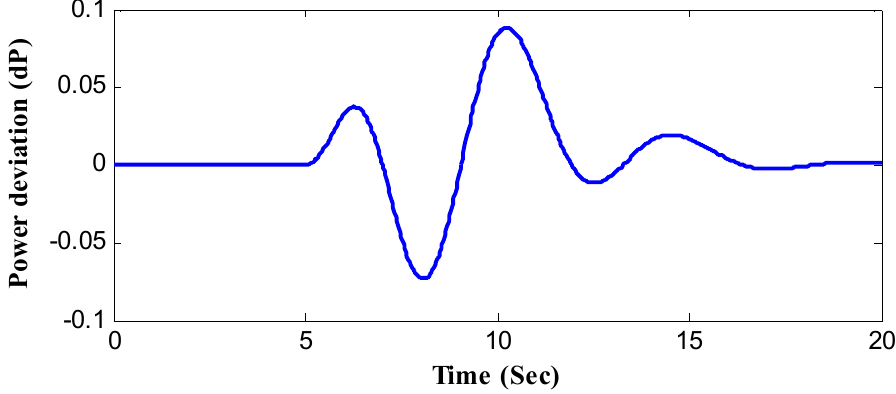
Figure 7. Frequency deviation ( ∆ f 2 ) using conventional 2DOF-OPID controller.